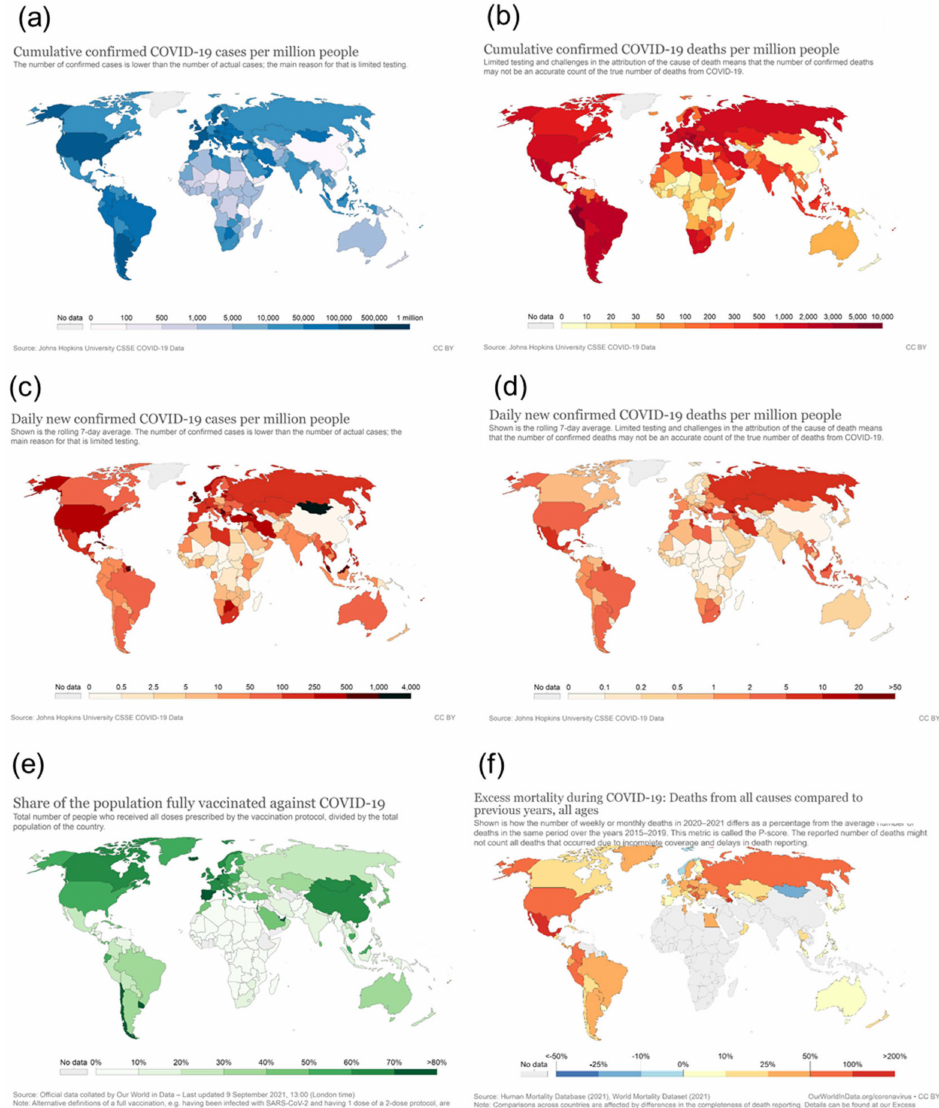
Figure 2. Cumulative confirmed COVID-19 cases per million people ( a ), cumulative confirmed COVID-19 deaths per million people ( b ), daily new confirmed COVID-19 cases per million people ( c ), daily new confirmed COVID-19 deaths per million people ( d ), share of the population fully vaccinated against COVID-19 ( e ), and excess mortality during COVID-19 (snapshot Jan 2021) ( f ). Source ( a – e ): https://ourworldindata.org/ (accessed on 8 September